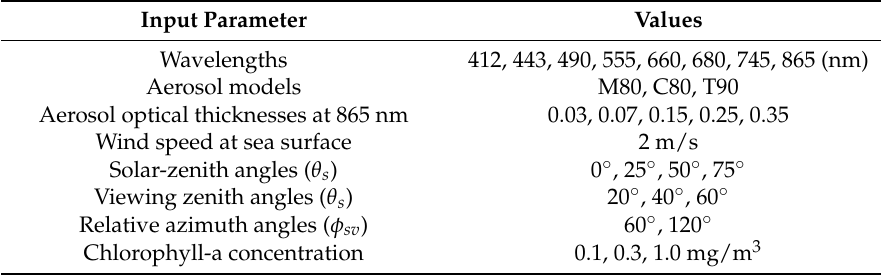
Table 3. Summary of the input parameters for the